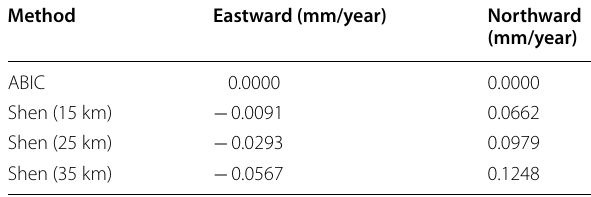
Table 2 Estimation bias of the velocity components